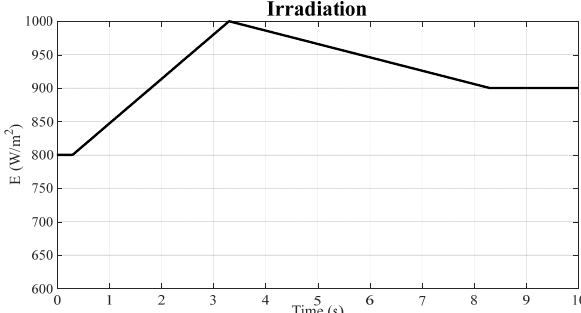
Figure 8. Irradiation variation (Scenario 5).